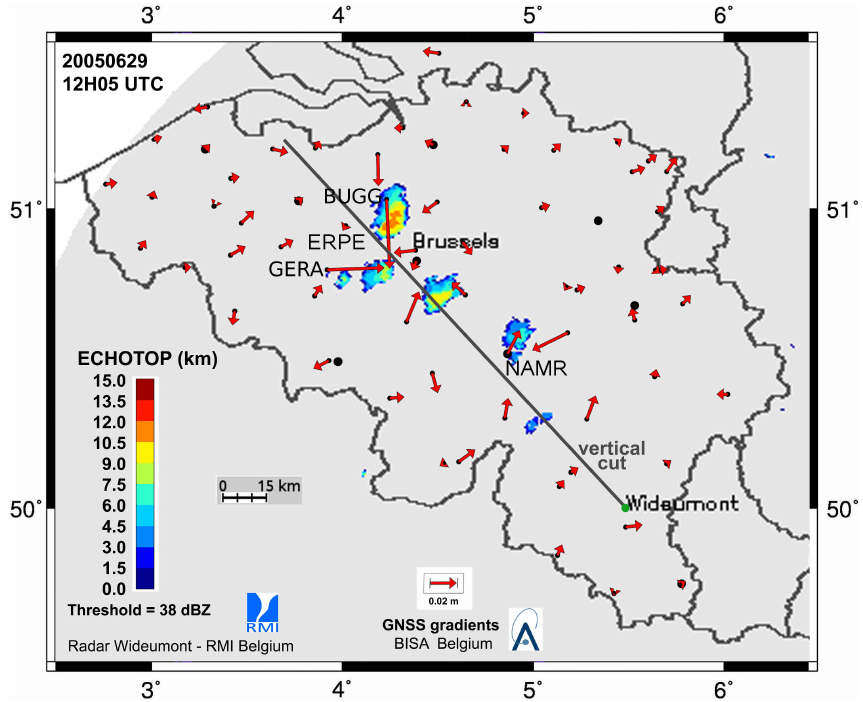
Figure 12. Altitude of the highest 38dBZ radar echo on 29 June 2005 at 12:05UTC. The black line shows the location of the vertical cut of radar reflectivity presented in Fig. 13. GNSS gradients are plotted with red arrows on stations (small black circles). The main Belgium cities are shown by big black circles and the Wideumont weather radar with a green